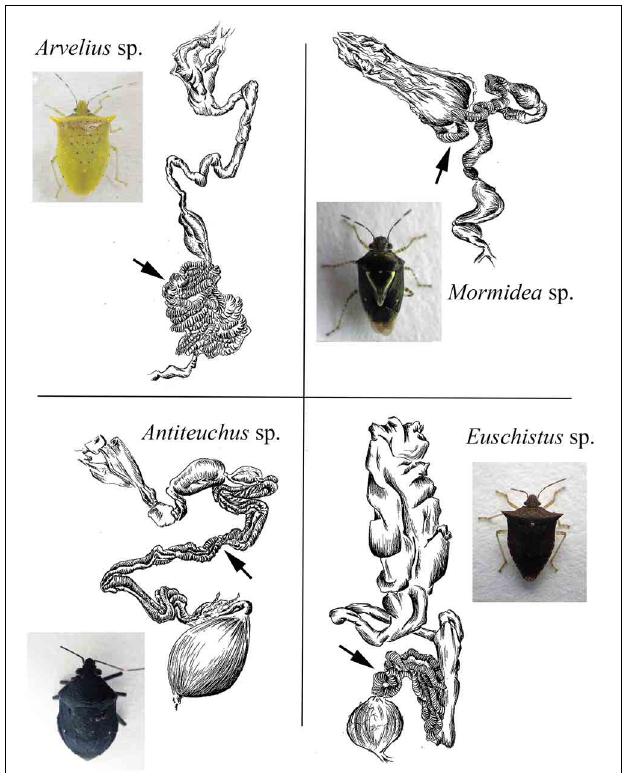
examined in this study. Arrows denote the symbiont-containing ceca, with crypts. Similar sketches for Sibaria englemani and Edessa n sp 1 are shown in Figures 3 , 4